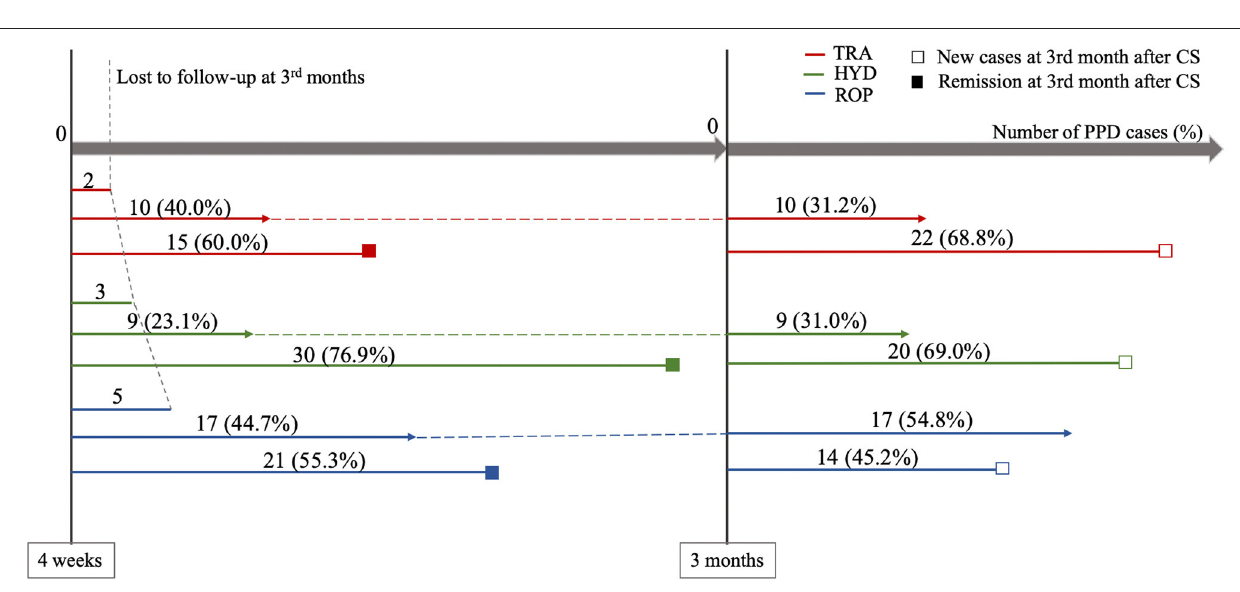
FIGURE 3 | Remission rate at 3 months after CS and proportion of new cases of PPD between 4 weeks and 3 months. The red (2), green (3), and blue (5) short lines on the left of figure represented the subjects suffering from PPD at the 4 weeks after CS, which were lost to follow-up at the 3 months. The lines in the middle of three colors (10, 9, and 17) that followed by dashed lines to the next time point, represented the subjects suffering from PPD at 4 weeks and 3 months after CS. The lines at the bottom of three colors (15, 30, and 21) that marked with solid boxes, represented the subjects suffering from PPD at 4 weeks but remitted at 3 months after CS. The three lines (22, 20, and 14) on the right side of figure that marked with hollow boxes, represented new PPD cases at 3 months after CS. TRA, Tramadol PCIA; HYD, Hydromorphone PCIA; ROP, Ropivacaine PCEA; PPD, Postpartum depression; CS, cesarean